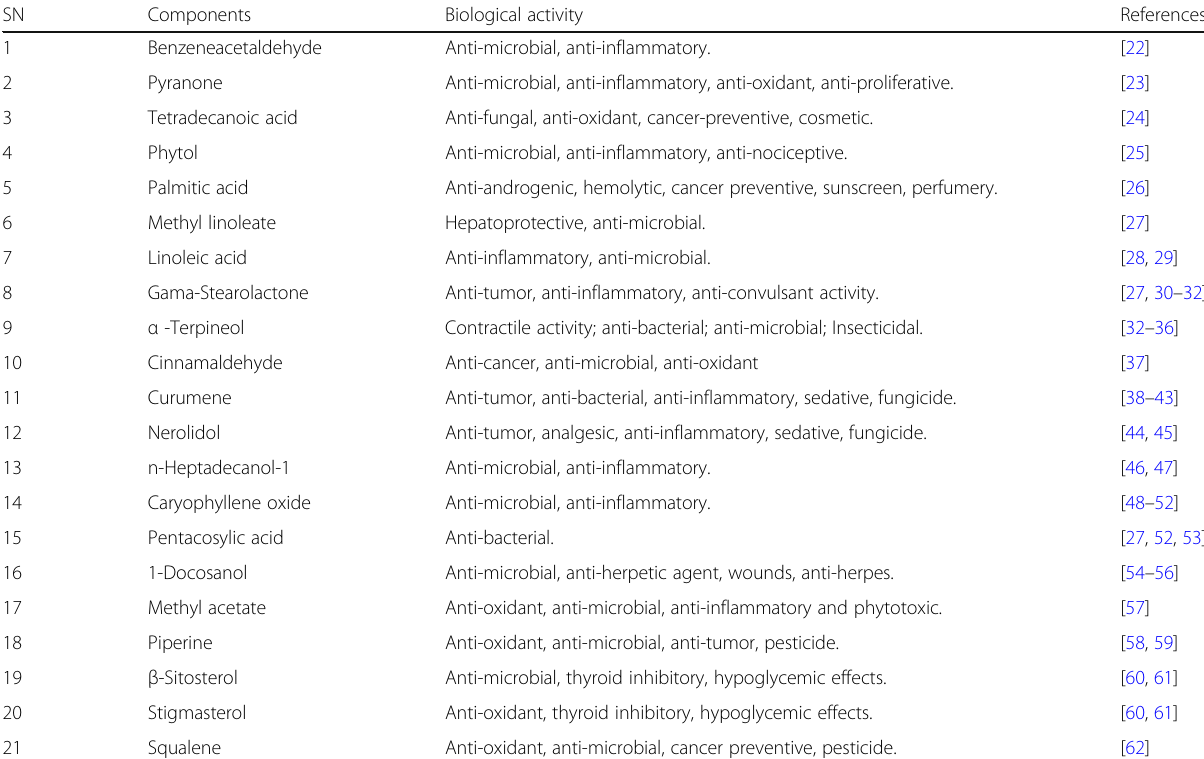
Table 5 Bioactive components present in the methanolic extracts of leaves and flowers of Saussurea obvallata